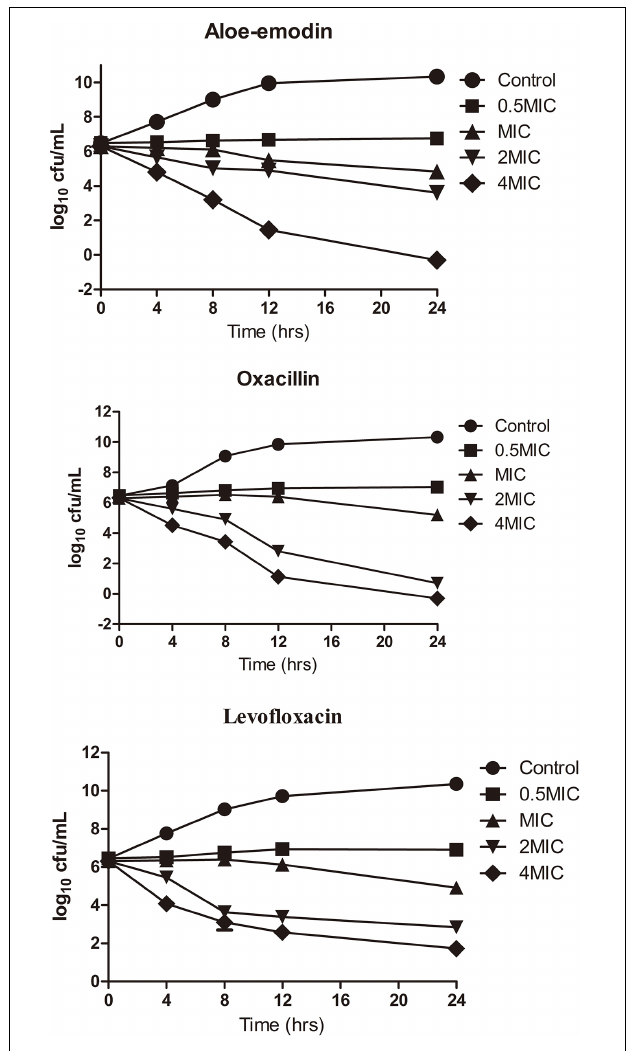
FIGURE 3 | Killing kinetics of aloe-emodin against Staphylococcus epidermidis strain BNCC102555. Change in CFU/mL at 0, 4, 8, 12, and 24 h after the addition of 0.5 × , 1 × , 2 × , and 4 × the MIC of aloe-emodin, levofloxacin, and oxacilin. A non-treatment group was included as a control. The values plotted are the mean ± S.E.M for three replicates. After 4 h of incubation, the number of live bacteria in the control was significantly higher than in the other groups ( P <